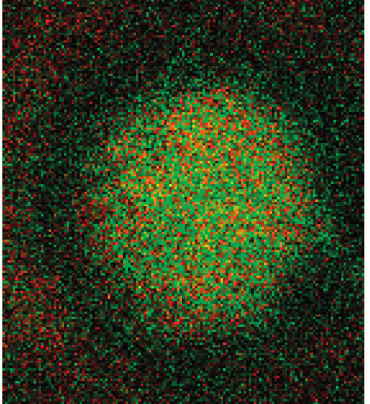
Figure 16. Merger of red (band 3) and green (spectrin) channels of the confocal microscope after examination of double stained erythrocytes suspended in autologous plasma (reprinted from reference [21]; Primary magnification: 1:63; zoom factor